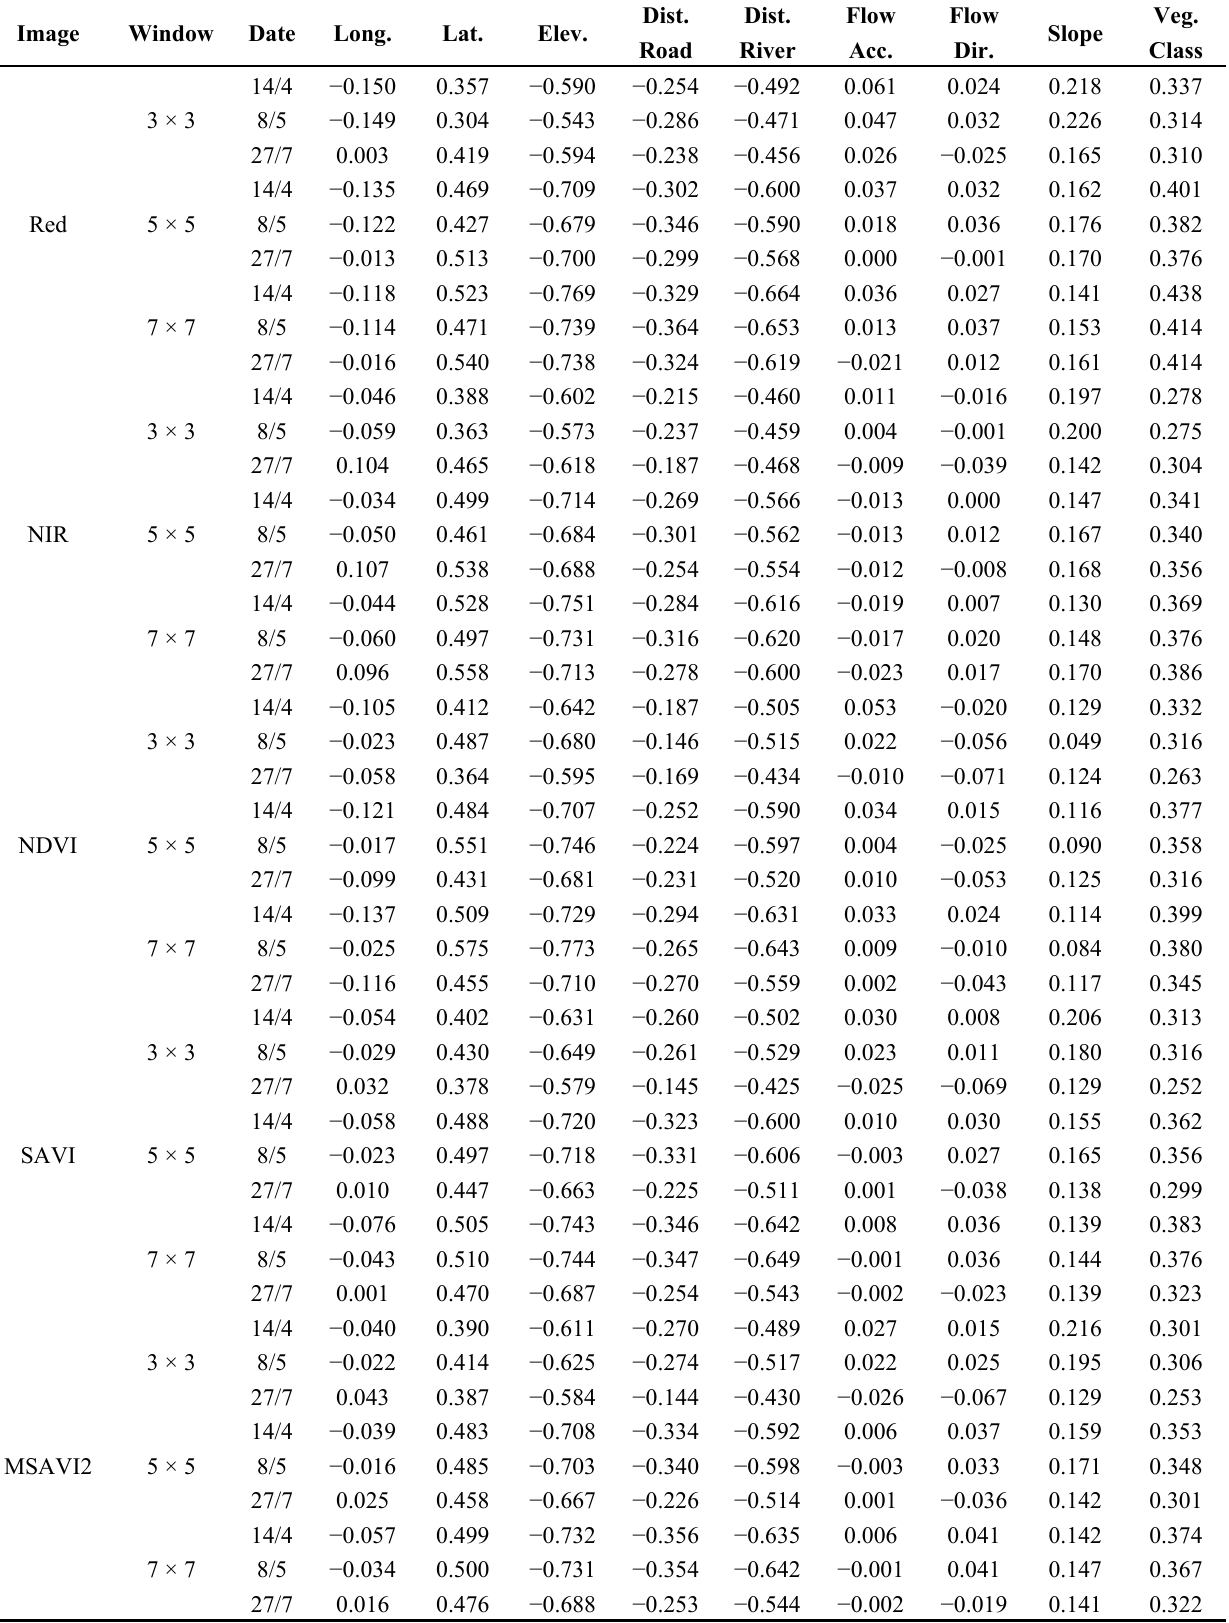
Table 3. Pearson’s correlation coefficients between environmental covariates and Moving Standard Deviation Index (MSDI) values along the Chobe riverfront, Botswana. All dates are in